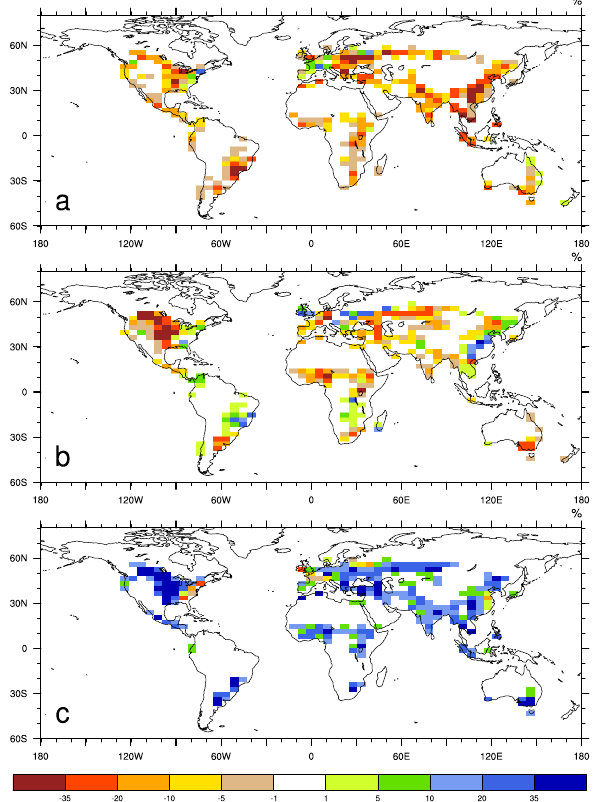
Fig. 1. Fractional changes in coverage of (a) woody, (b) grass, and (c) crop plant functional types for the period